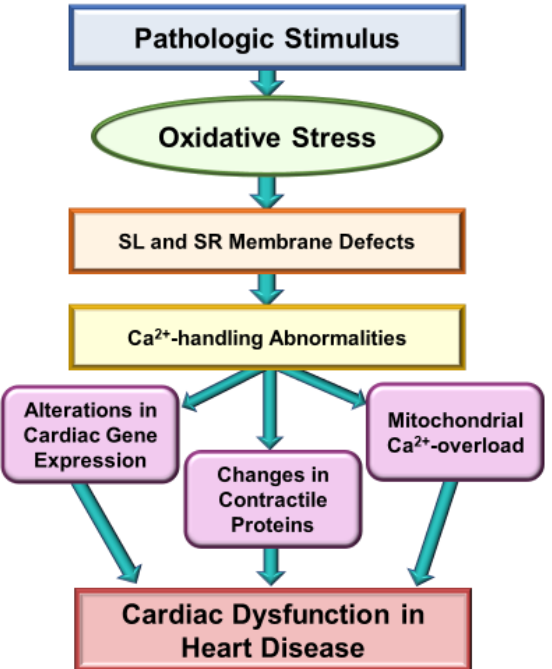
Figure 2. Role of Ca 2+ -handling abnormalities in oxidative stress induced cardiac dysfunction in heart disease. SL, sarcolemma; SR, sarcoplasmic reticulum.